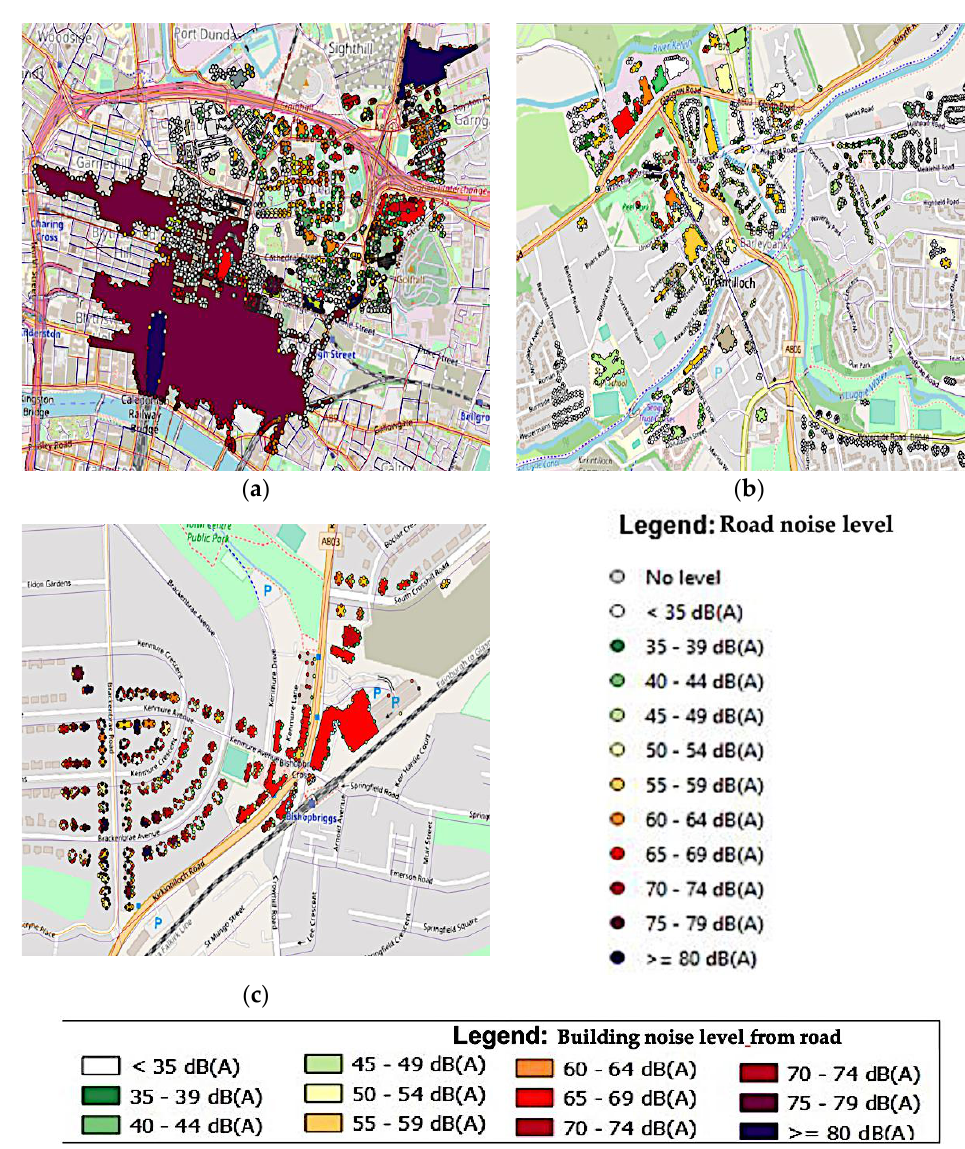
Figure 6. A model of annual road traffic noise levels (Lden) at monitoring areas at five monitoring locations (23 November 2021): ( a ) Community noise level (Lden)at GHS, GT, and GK; ( b ) Community noise level (Lden)at EDK; ( c ) Community noise level (Lden) at EDB .